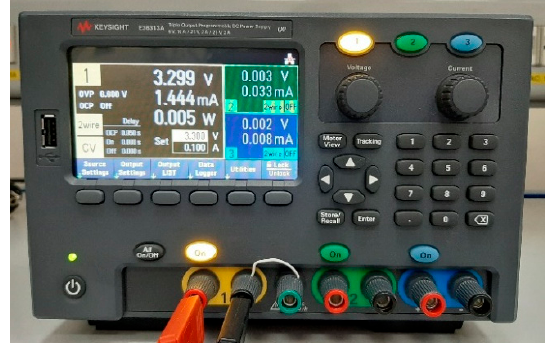
Figure 9. Power supply of the low-power analog front end, measuring the current drawn by the circuit.